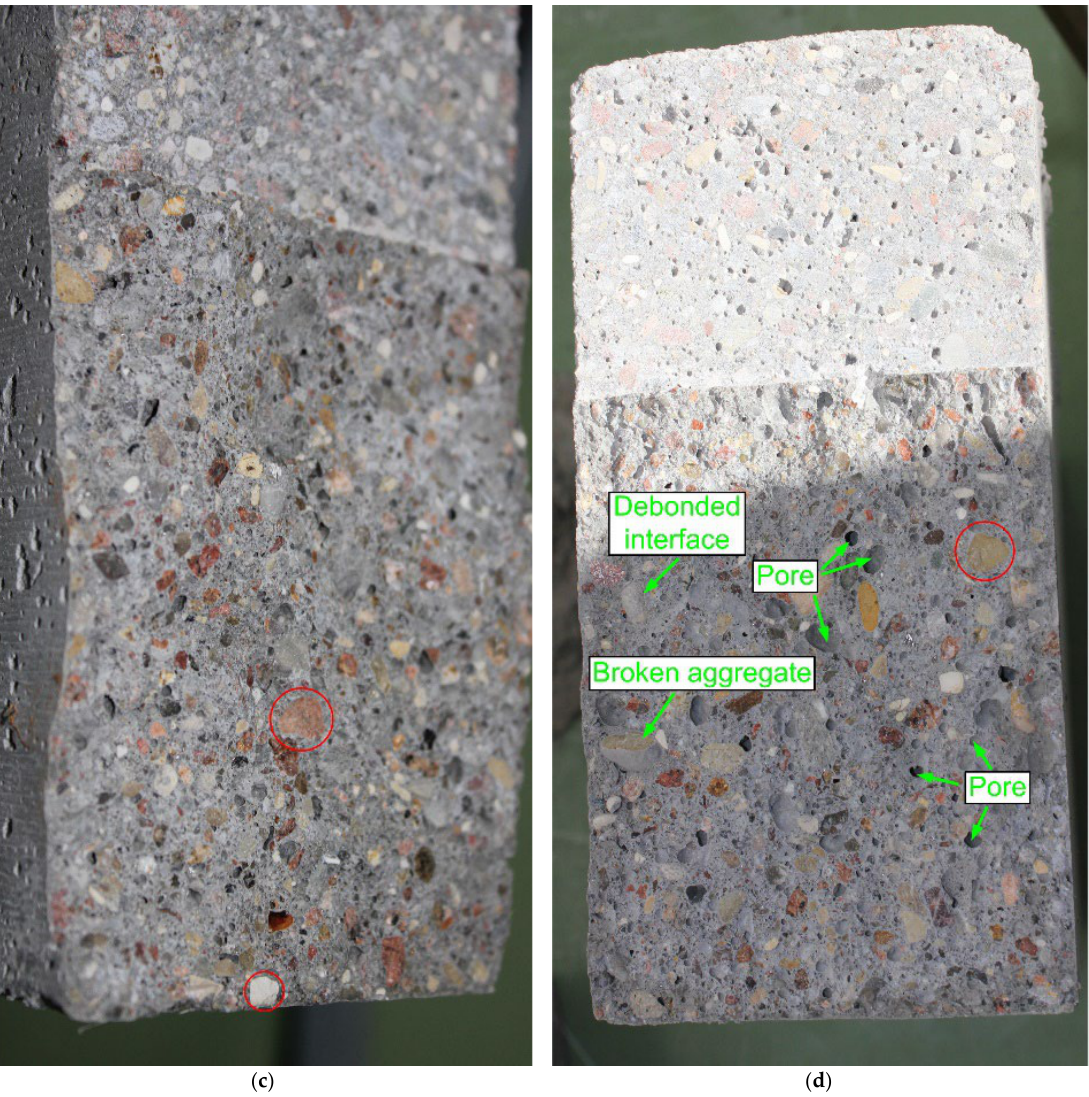
Figure 4. Cross-section of the analyzed concrete composites after a fracture toughness test, with visible characteristic macroscopic structure: ( a ) REF, ( b ) QBC-1, ( c ) QBC-2, ( d ) QBC-3.